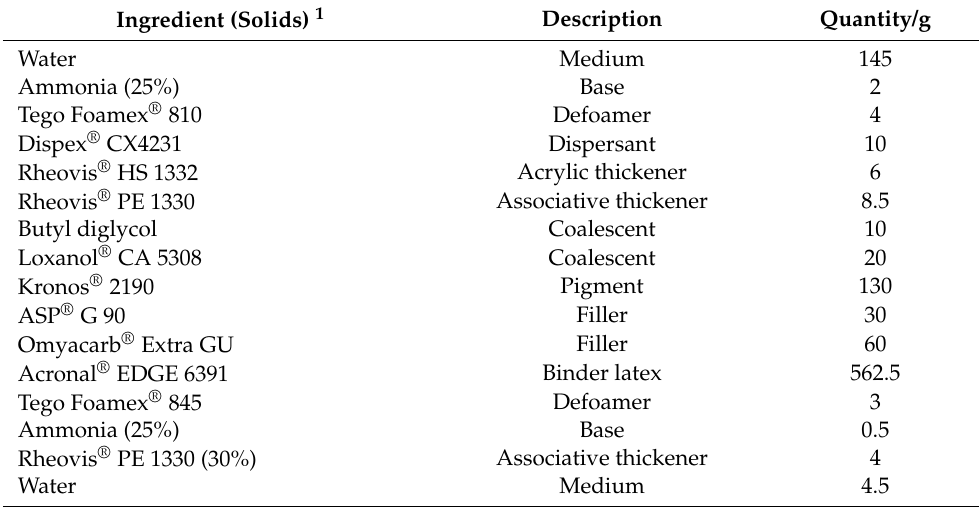
Table A2. White wood paint formulation for binders E to F. The solids content was 48%; the PVC was 23%; the pH was adjusted to 8.2–8.5 using ammonia. Additional brand names to Table A1 are each respective trademarks of Evonik SE (Tego Foamex ® ) (Essen, Germany), Eastman Chemical Inc. and BASF SE (ASP ® , Loxanol ® ). Ammonia and butyl diglycol were obtained from BASF SE, Ludwigshafen,